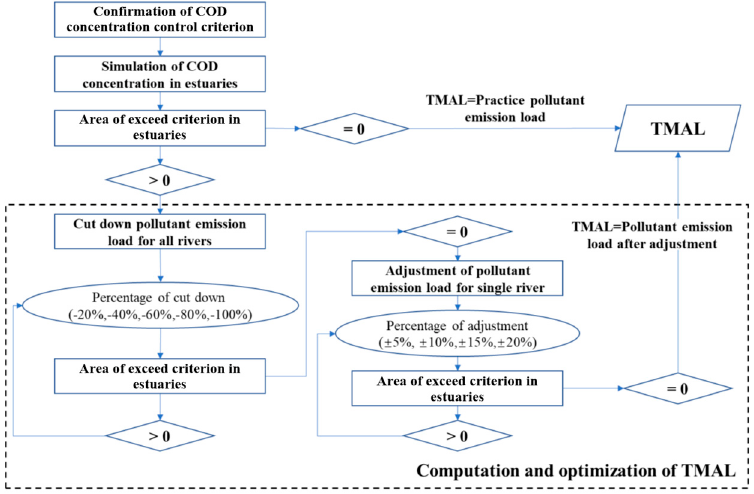
Figure 5. Computation procedures of total maximum allocated load (TMAL) with optimization process based on COD concentration simulation.